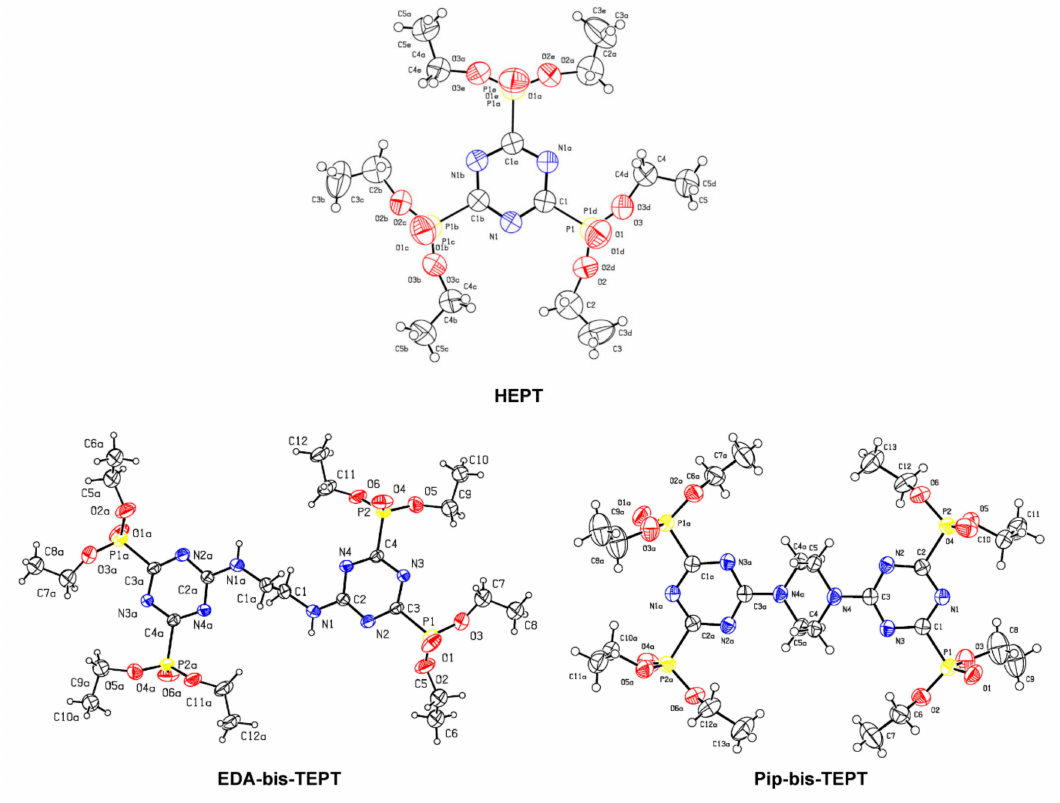
Figure 1. Molecular structures of HEPT, EDA-bis-TEPT, and Pip-bis-TEPT. Thermal ellipsoids are drawn with a 50% probability level [37]. Phosphorus (yellow), oxygen (red), and nitrogen (blue).